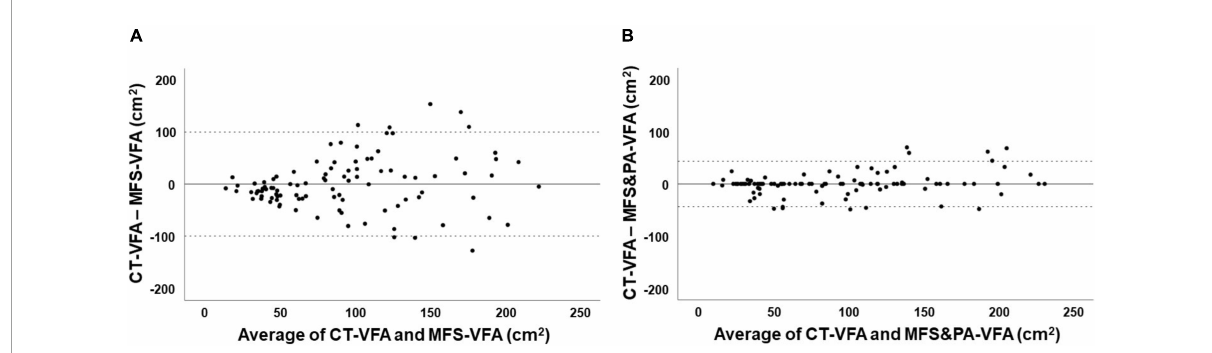
FIGURE2 Bland–Altman plot for comparing the two methods. (A) MFS-VFA and CT-VFA; (B) MFS&PA-VFA and CT-VFA. CT, computed tomography; VFA, visceral fat area; CT-VFA, VFA measured by CT; MFS-VFA, VFA measure by a multifrequency segmental bioelectrical impedance analysis (BIA) machine (InBody770 R (cid:13) ); MFS&PA-VFA, VFA measured by a new MFS-BIA machine combined with a portable abdominal BIA device (InBody970 R (cid:13) + Y-scope R (cid:13)